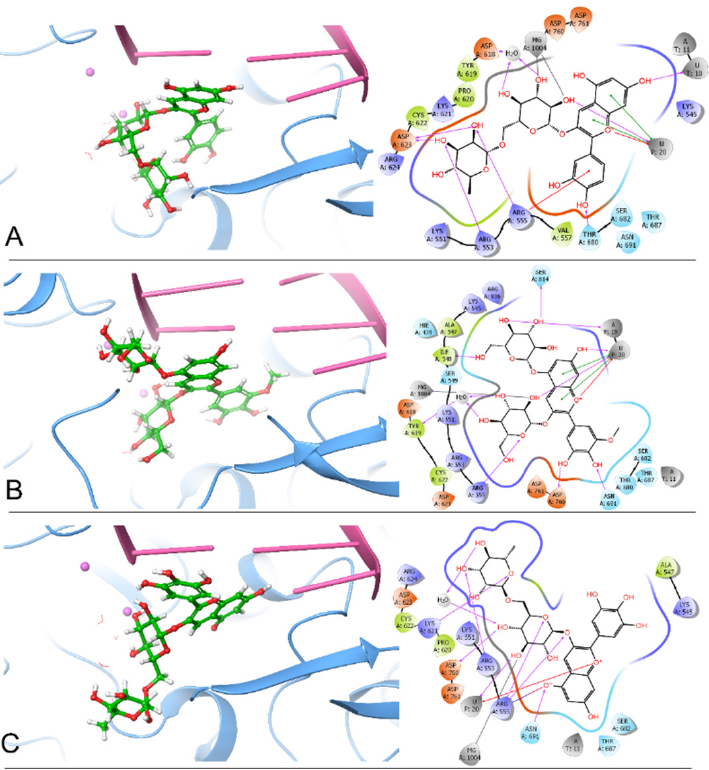
Figure 1. The docking poses and 2D ligand–protein interaction diagrams of 7BV2 and the top three ligands: ( A ), Cyanidin 3- O -rutinoside; ( B ), Petunidin 3,5- O -diglucoside; ( C ), Delphinidin 3- O -rutinoside. The pink spheres represent Mg 2+ ions. The purple arrows indicate the hydrogen bonds; the green line represents π - π stacking; the red line represents π –cation interaction; the blue-red line represents the salt bridge; the gray line represents metal coordination.